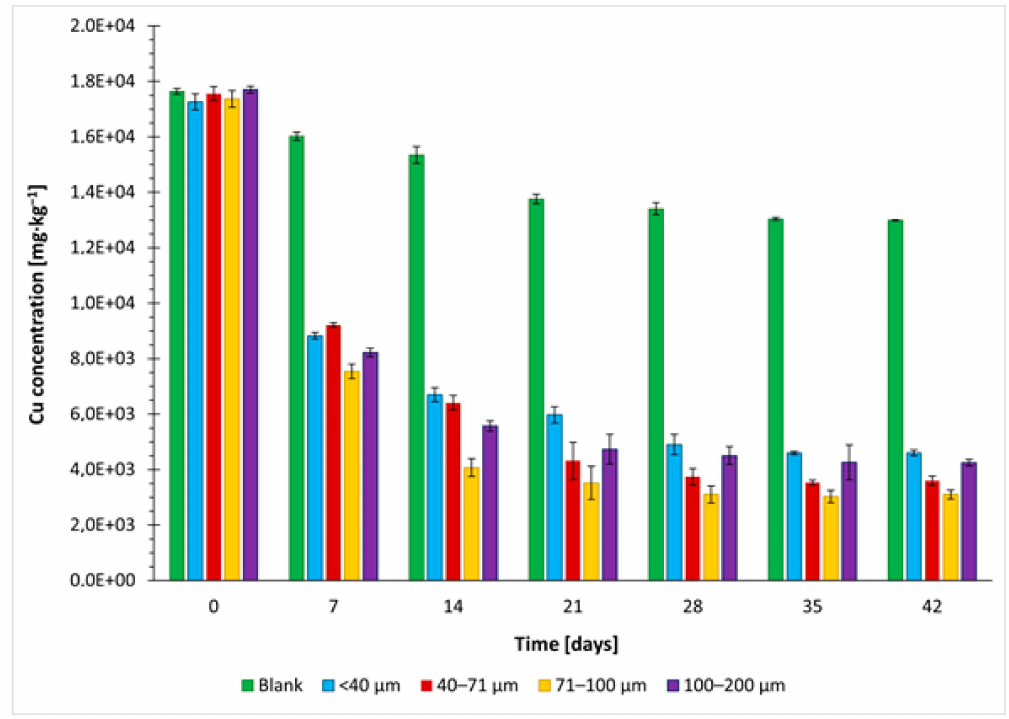
Figure 8. Concentration loss of Cu in waste material for individual grain fractions.